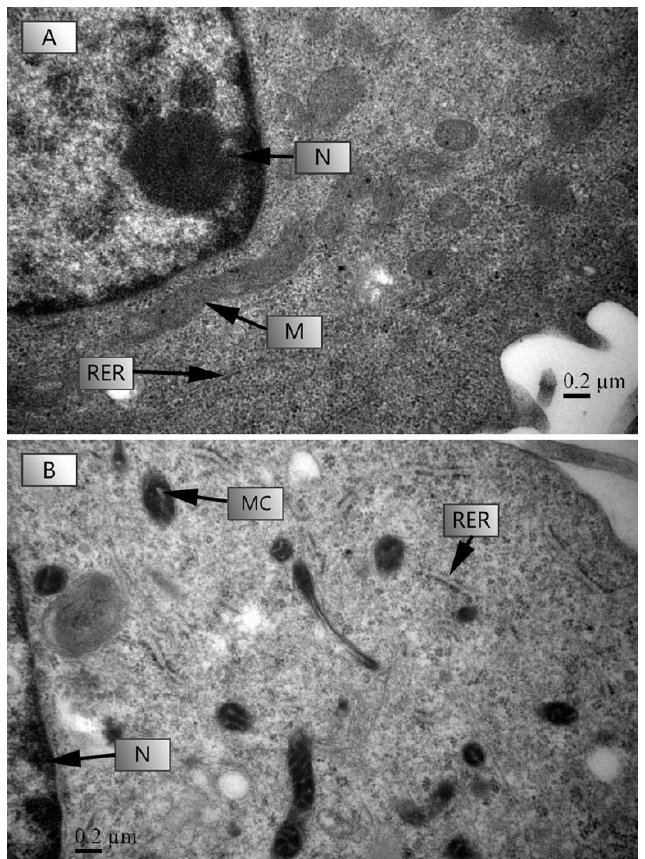
Figure 5. The effects of TC on the ultrastructural changes in HL-7707 cells. Note: ( A ): tetracycline 0 μg L −1 ; ( B ): tetracycline 1000 μg L −1 ; Arrows: N: nucleus; RER: rough endoplasmic reticulum; M: mitochondria; MC: mitochondrial cristae. Six to seven images were taken to get a representative image.